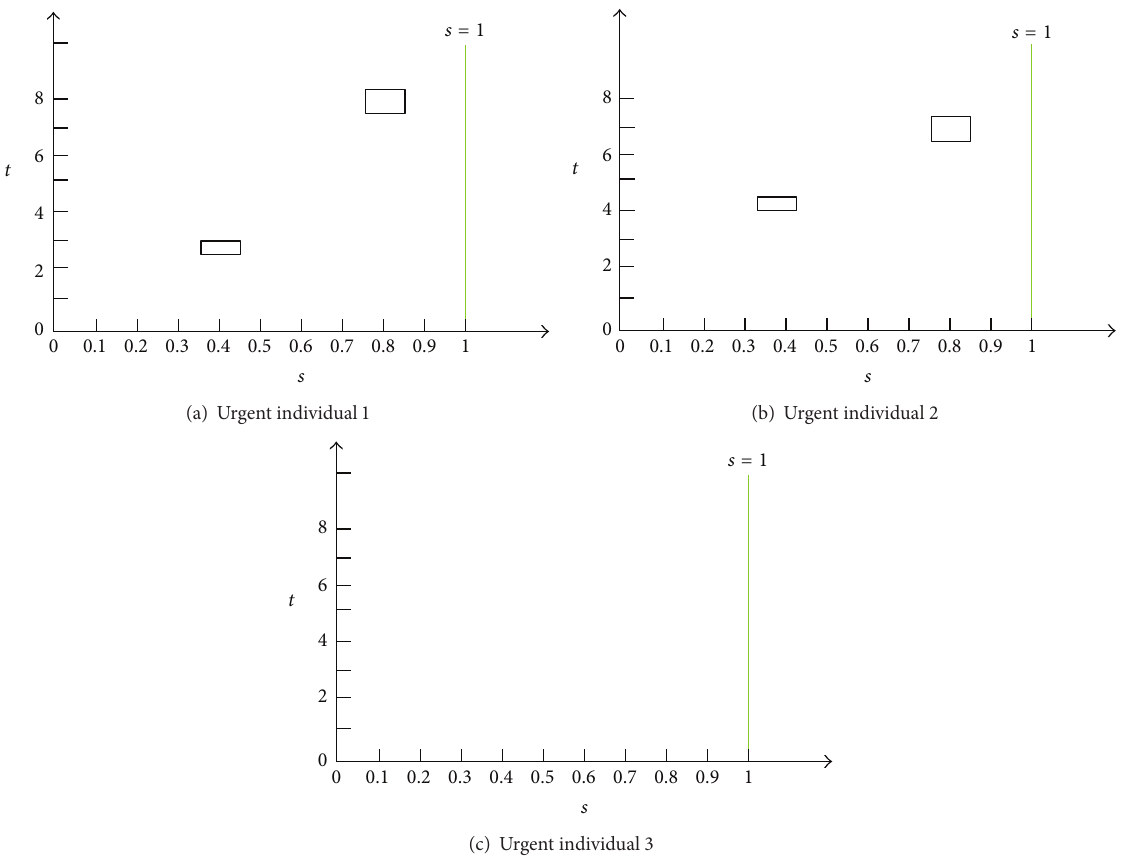
Figure 7: The 𝑠 × 𝑡 spaces of urgent